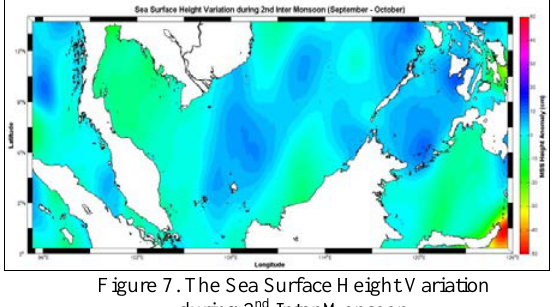
Figure 7. The Sea Surface Height Variation during 2 nd Inter Monsoon